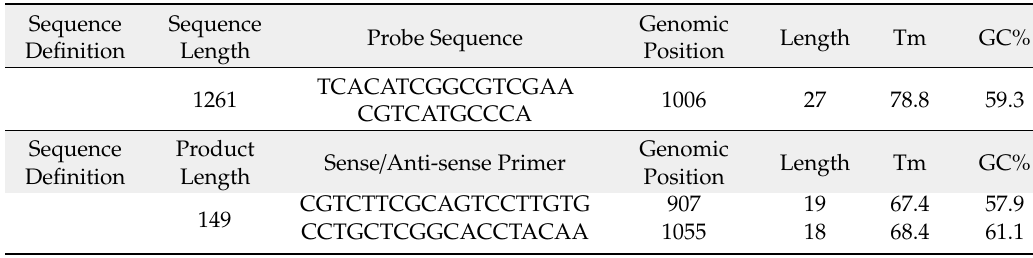
Table 4. Sequence information for probe and primers in this